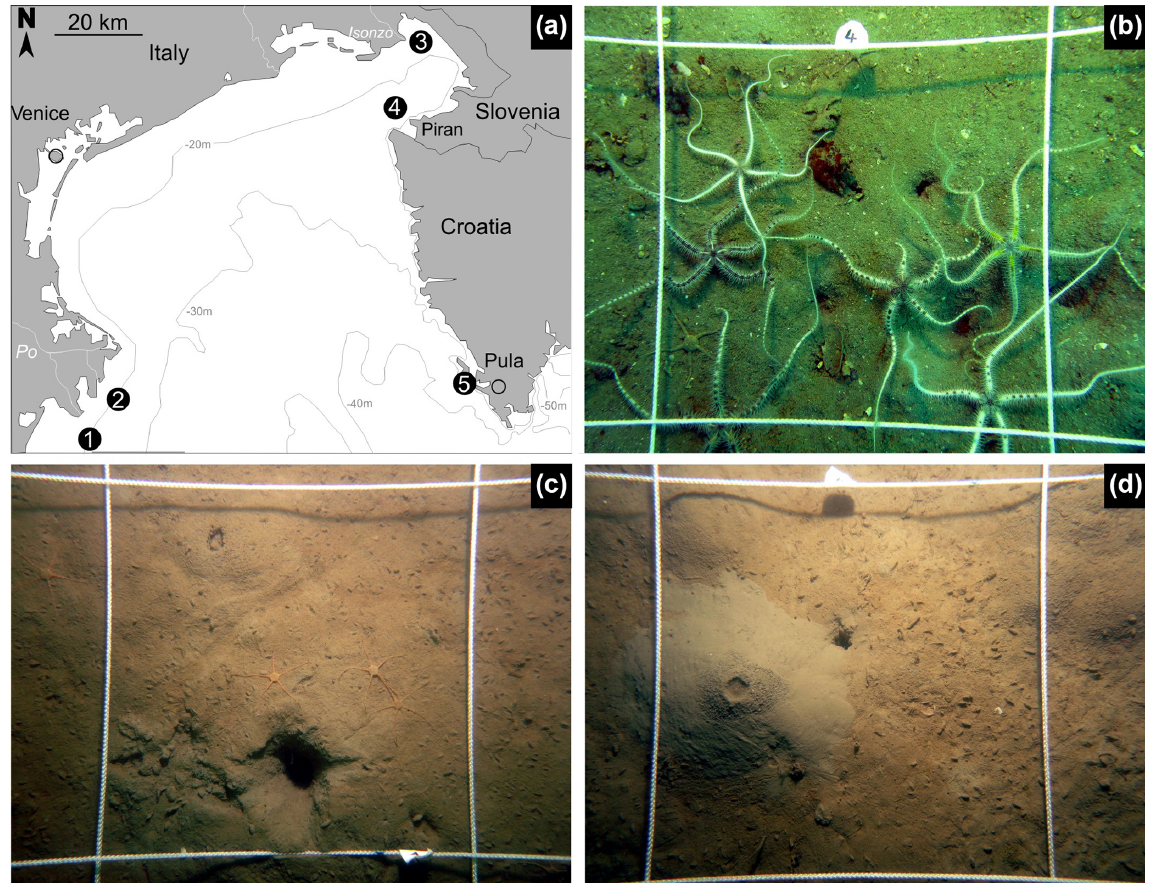
Figure 1. (a) Geographic map with the locations of five sites analyzed in this study: 1 – Po 4 (with two replicate cores M20 and M21), 2 – Po 3 (with two replicate cores M13 and M14), 3 – Bay of Panzano in the northern Gulf of Trieste (with two sediment cores M28 and M29), 4 – Piran (M53 core), and 5 – Brijuni (M44). Sea floor photographs taken in 2014 at Piran ( b , with abundant Ophiothrix ), Po 4 ( c , with abundant Ophiura albida ), and Po 3 (d) documenting abundant burrow and mound structures and uneven topography. The size of the square is 25cm 2 . The thickness of the mixed layer at Po is ∼ 20cm on the basis of both 14 C and 210 Pb and also at Brijuni and ∼ 8cm at Piran, underlain by a shell